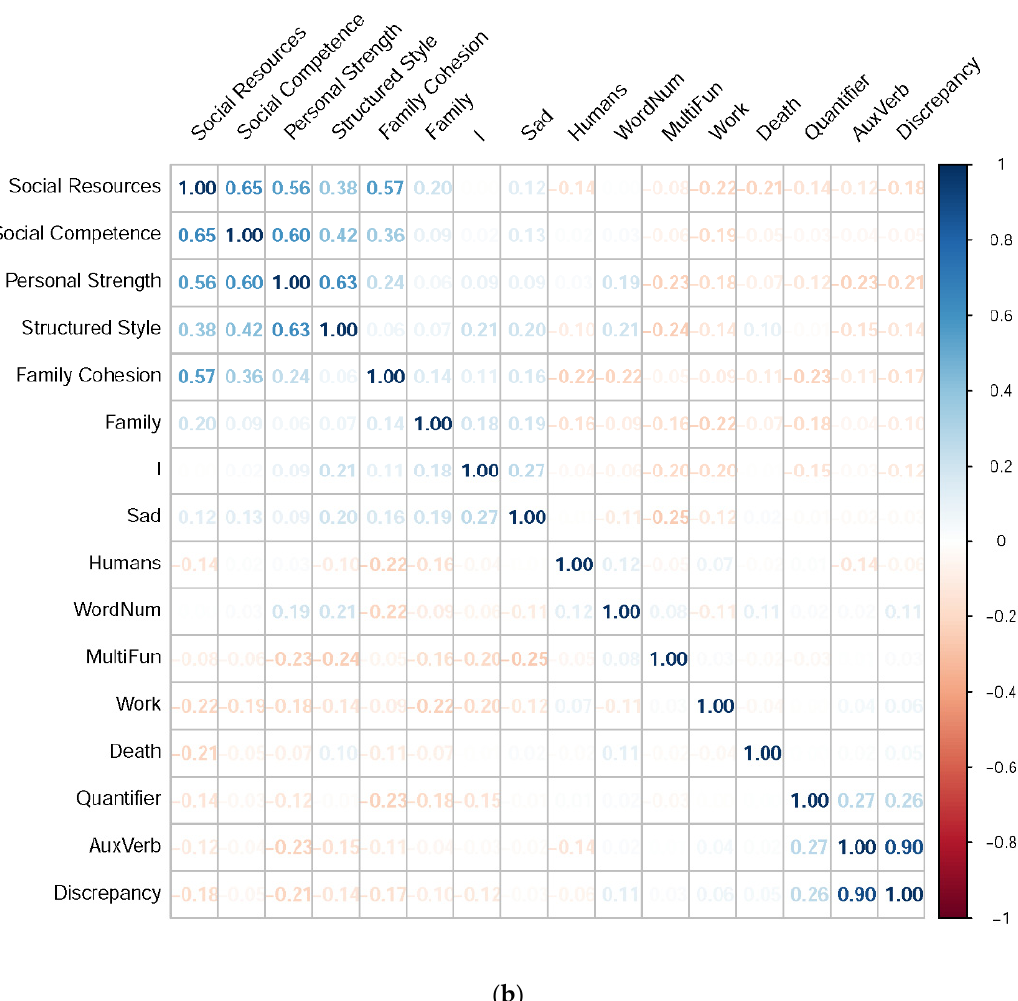
Figure 6. ( a ). The correlations between each RSA score and each TC-LIWC linguistic feature (only negative memories). Because there were many statistically significant correlations ( p < 0.05), only linguistic features with at least one |r| > 0.2 were included in this plot. MultiFun = multifunction words; NegEmo = negative emotion; QuantUnit = quantity unit; WordNum = number of words. ( b ). The correlations between each RSA score and each TC-LIWC linguistic feature (positive and negative memories). Because there were many statistically significant correlations ( p < 0.05), only linguistic features with at least one |r| > 0.2 were included in this plot. AuxVerb = auxiliary verbs; MultiFun = multifunction words; NegEmo = negative emotion; WordNum = number of words.